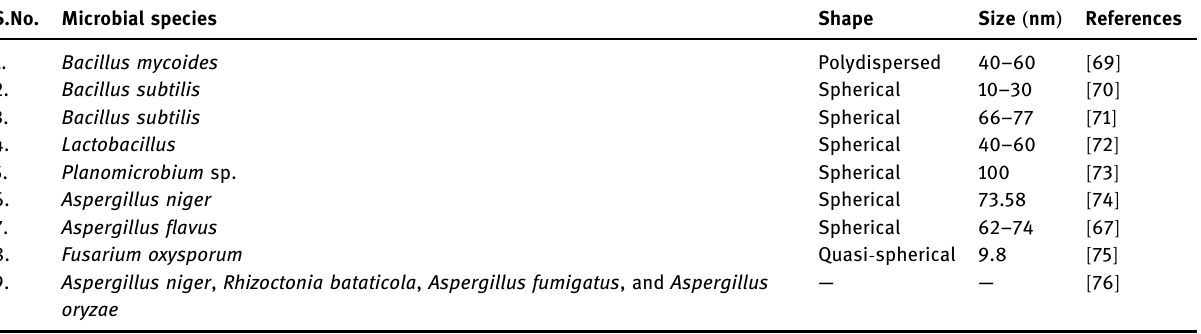
Table 2: Various microbial species with di ff erent morphologies for the synthesis of TiO 2 - NPs S.No. Microbial